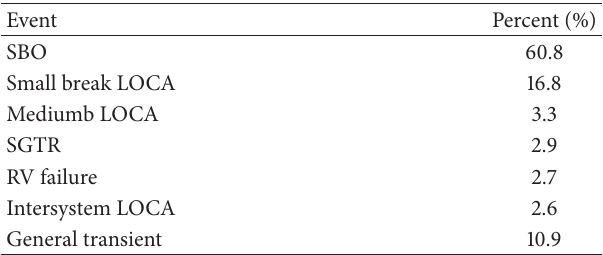
Table 1: Level 1 PSA initiating